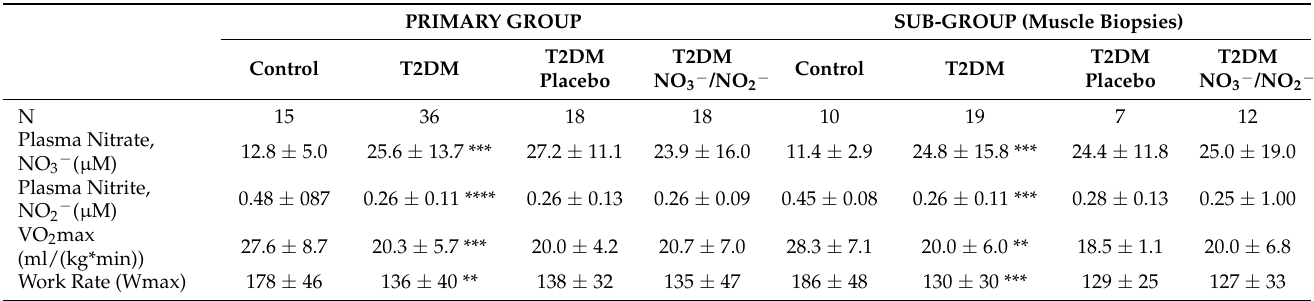
Table 2. Baseline plasma NO metabolites and cardiorespiratory